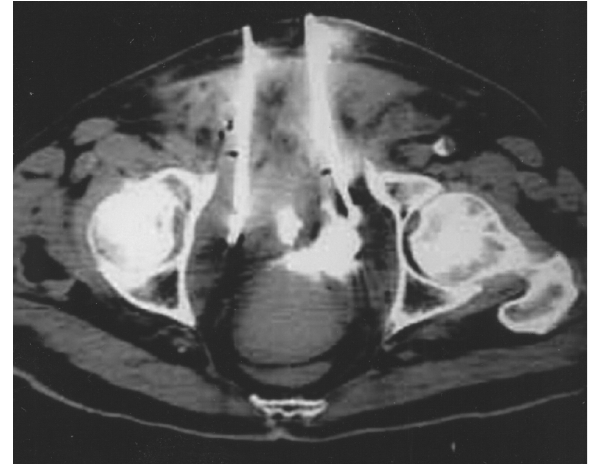
Figure 3 - Complete dehiscence of bladder neck with escape of Foley catheter associated to cranial displacement of the